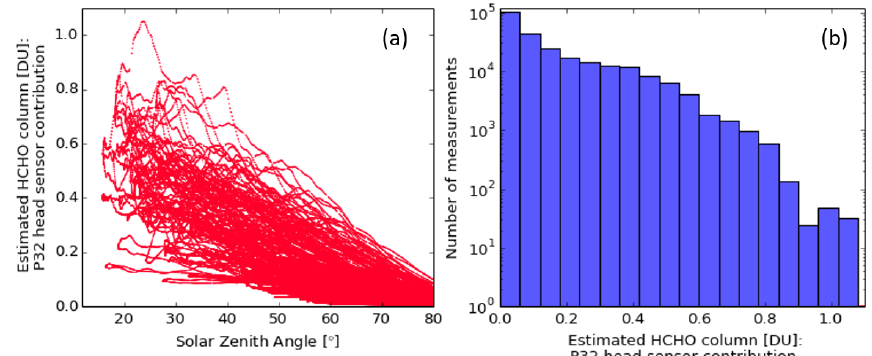
Figure 10. Estimated HCHO column density inside Pandora 32 head sensor during deployment at NASA-GSFC, Greenbelt, MD (17 July 2019–7 February 2020). Estimation is based on the exponential function amplitude derived from Pandora 32 and Pandora 2 direct-sun measurements of HCHO (0.0133DU) and the exponential function damping coefficient derived from the laboratory measurements of four other instruments (0.091). Direct-sun air mass factors used to calculate HCHO are limited to solar zenith angles smaller than 80 ◦